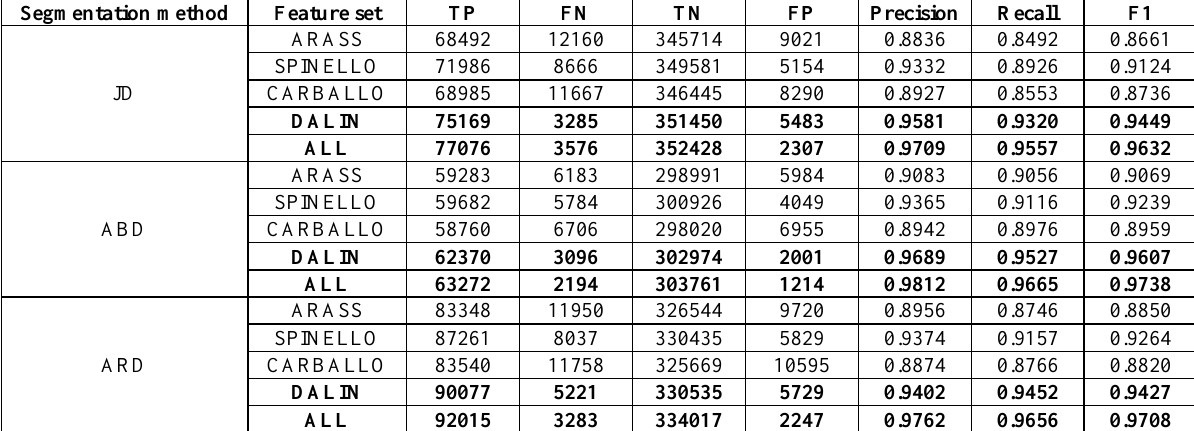
Table 7. Classification results of leg segments by different methods for data set